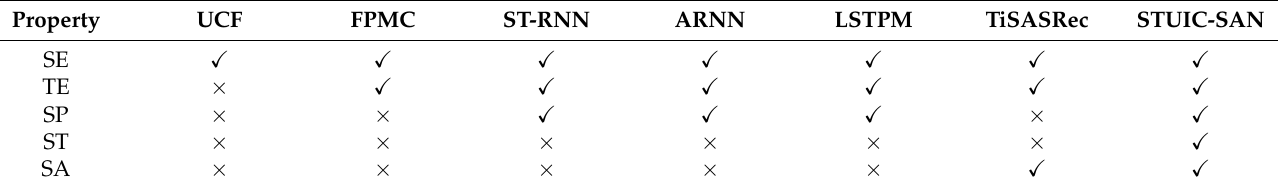
Table 3. The approaches used in our experiments.